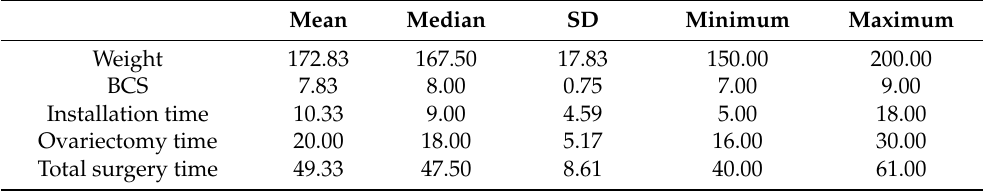
Table 1. Weight, BCS, and surgical variables. The table summarize weight (kg), body condition score, total surgery time (min) from the first skin incision to the last scheme 45 recumbency. Time variables are expressed in min, mean, median, standard deviation (SD), and